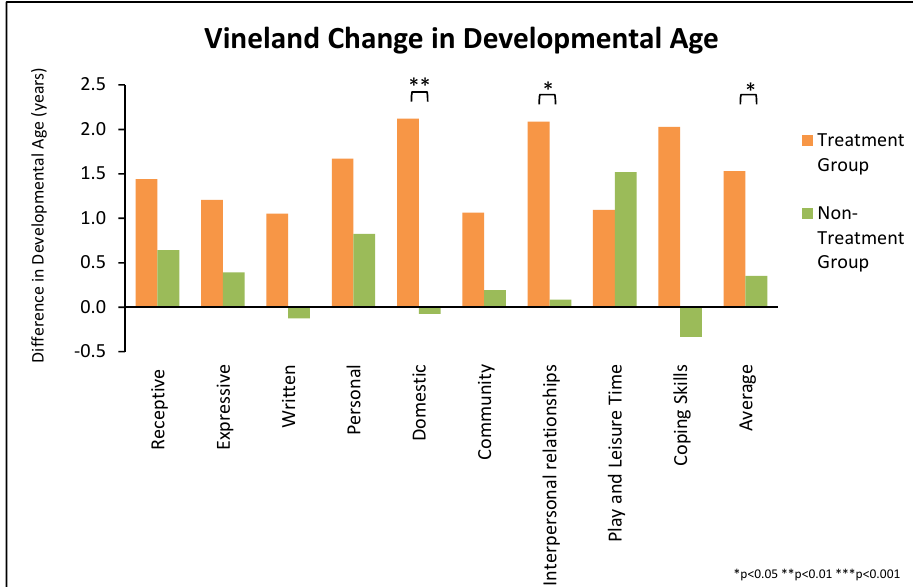
Figure 7. Vineland Subscale Changes.